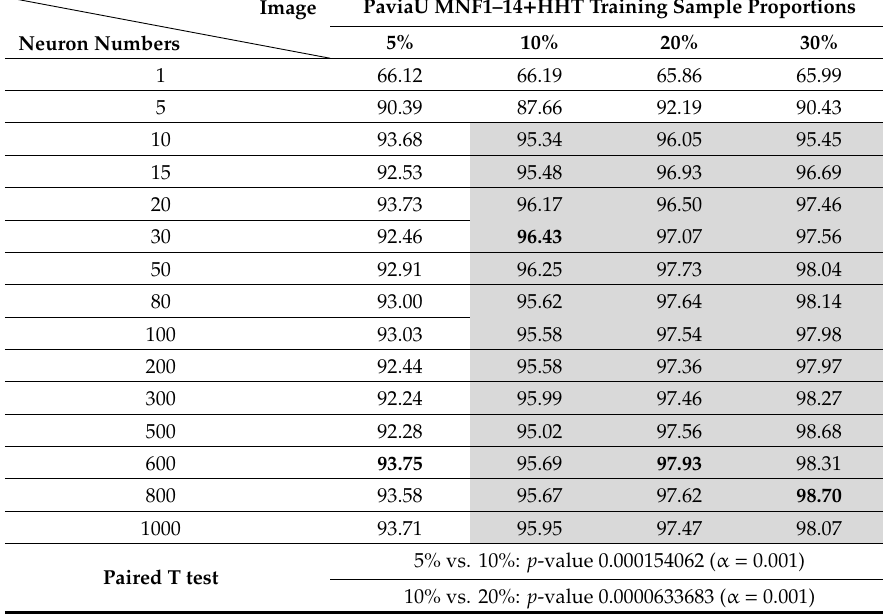
Table 4. Classification accuracy results of PaviaU MNF1–10 + HHT image set with di ff erent training sample proportions using 1 to 1000 neurons. The highest accuracy value in the corresponding training sample proportion column is shown in bold, and values above 95% are shaded in light